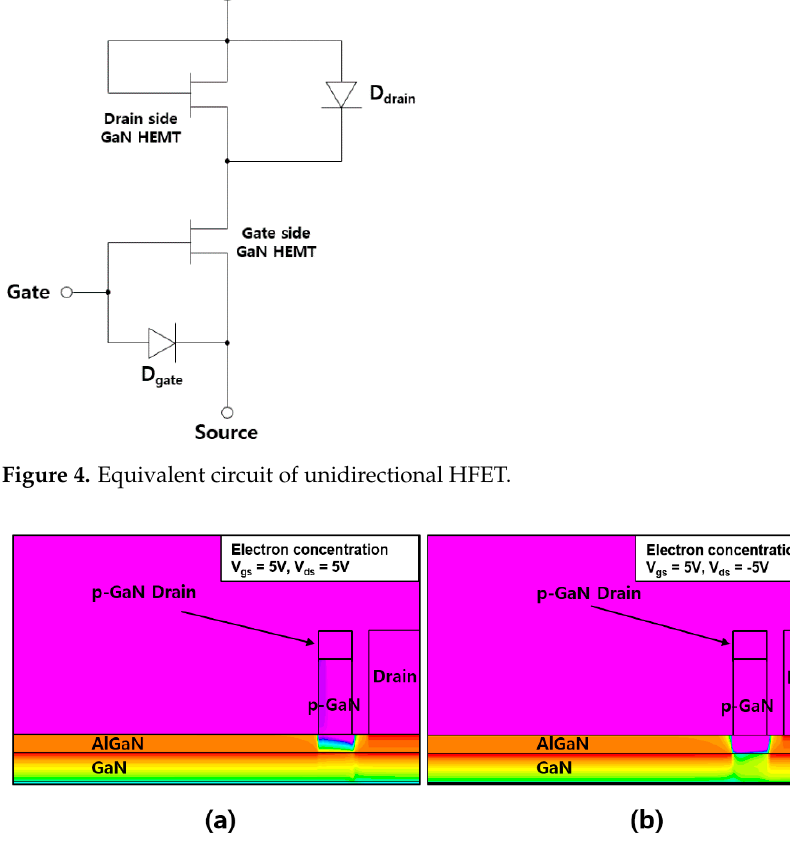
Figure 5. Electron concentration under the p-GaN drain region at ( a ) V gs = 5 V and V ds = 5 V and ( b ) V gs = 5 V and V ds = − 5 V. Two electrodes (p-GaN drain and drain electrodes) are shorted electrically to each other in the simulation.